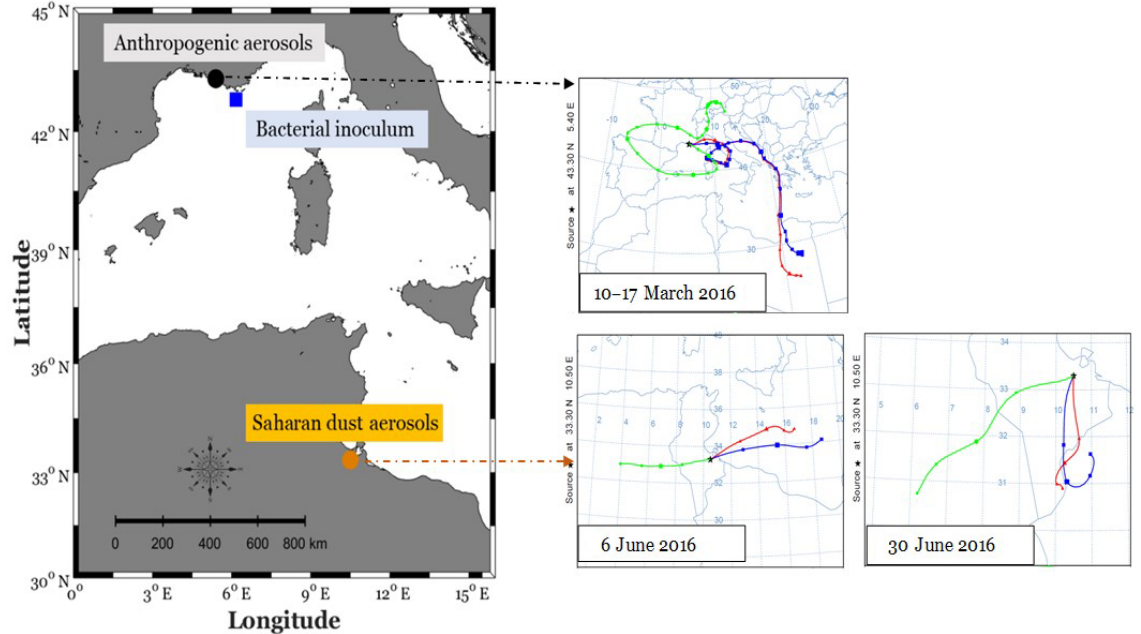
Figure 1. Sampling stations for anthropogenic aerosols (Marseille, southeast of France) and Saharan dust aerosols (Medenine, south- east of Tunisia), as well as for bacterial inoculum (MOOSE-Antares offshore station in the northwestern Mediterranean Sea). Backward air mass trajectories are represented for the periods during which anthropogenic (10–17 March 2016) and Saharan dust aerosols (6 and 30 June 2016) were sampled, using the HYSPLIT trajectory model (https://www.ready.noaa.gov/hypub-bin/trajtype.pl?runtype=archive, last access: 27 April 2020).